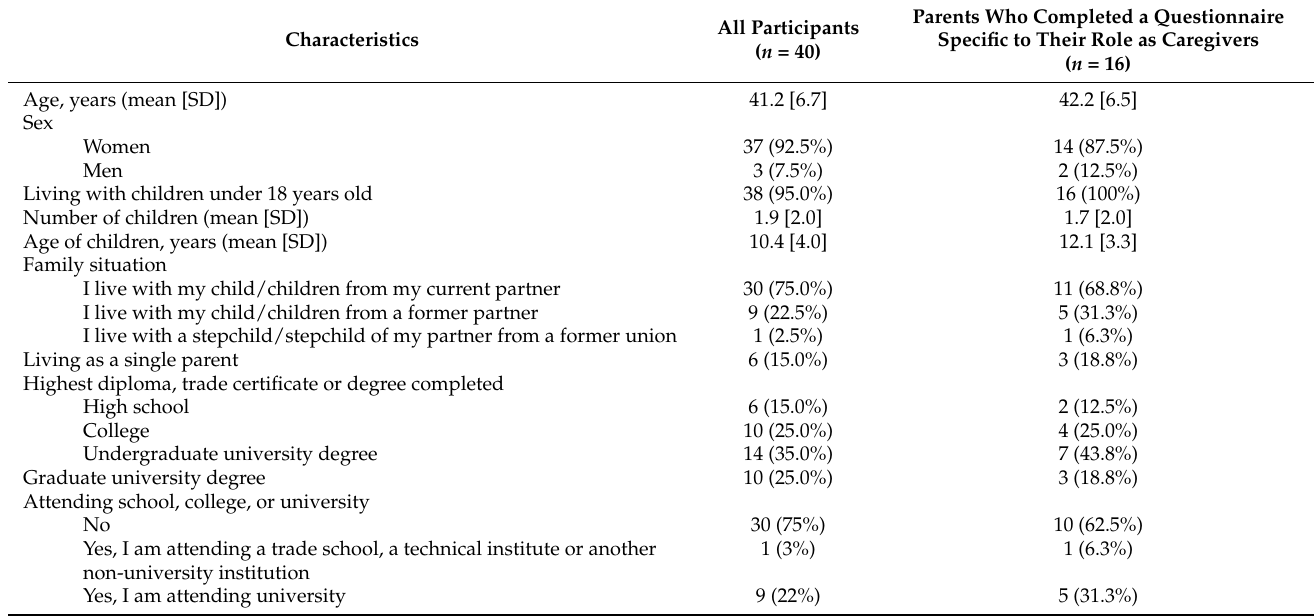
Table 1. Characteristics of the parents of children with disabilities from Quebec province (Canada) during the COVID-19 pandemic